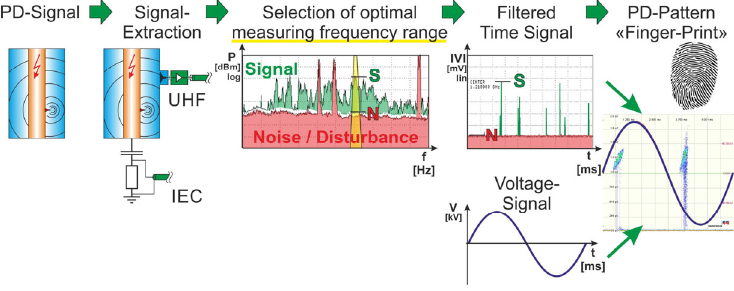
Figure 16. UHF measurement principle with a spectrum analyzer [30].